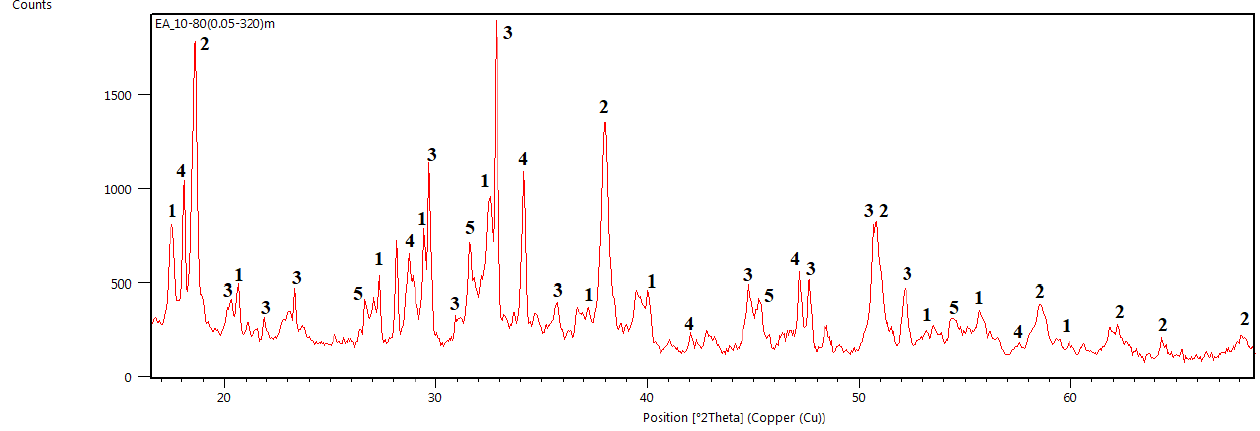
Figure 2. Main identified phases detected in steel slag sample: (1) Calcium Aluminum Silicate Hydroxide; (2) Magnesium Hydroxide; (3) Calcium Silicate; (4) Calcium Hydroxide; (5) Calcium Silicate Hydroxide Hydrate.